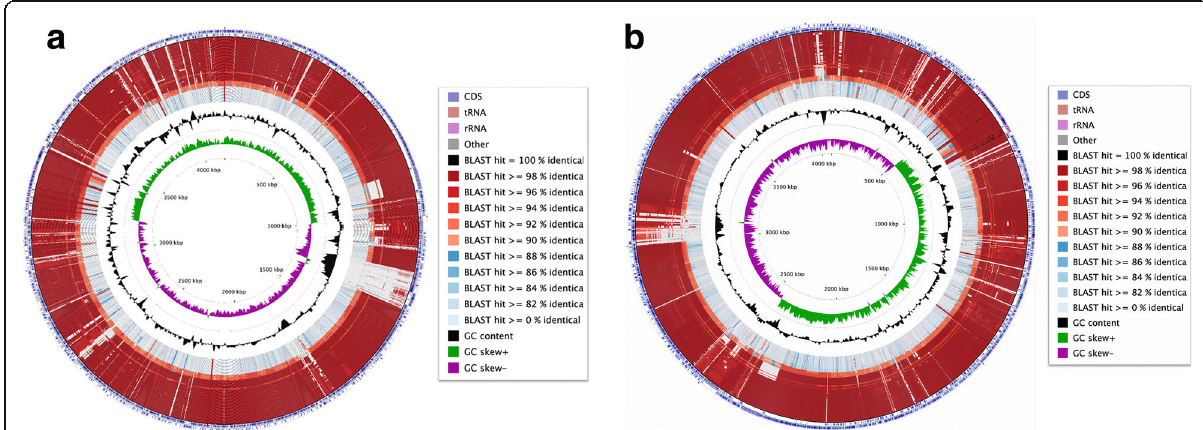
Fig. 2 a Visualizing features, ORFs, start and stop codons of B. subtilis HMNig-2 genome, and comparing the sequence with proteins encoded by other B. subtilis . This map was generated by CGview. The first and second [outermost] rings show the locations of protein coding, tRNA, and rRNA genes on the forward and reverse strands, respectively. All subsequent rings, with the exception of the two innermost plots, display regions of similarity detected using BLAST [ E value = 0.1] between the HMNig-2 genome sequence and the genome sequences of several related sequences [ n = 100]. Regions of similarity are colored based on the percent identity between the aligned sequence segments. The black plot depicts GC content with the peaks extending towards the outside of the circle representing GC content above the genome average, whereas those extending towards the center mark segments with GC content lower than the genome average. The innermost plot depicts GC skew. Both base composition plots were generated using a sliding window of 50,000 nt. b Visualizing features, ORFs, start and stop codons of B. subtilis MENO2 genome, and comparing the sequence with proteins encoded by other B. subtilis . This map was generated by CGview. The first and second [outermost] rings show the locations of protein coding, tRNA, and rRNA genes on the forward and reverse strands, respectively. All subsequent rings, with the exception of the two innermost plots, display regions of similarity detected using BLAST [ E value = 0.1] between the MENO2 genome sequence and the genome sequences of several related sequences [ n = 100]. Regions of similarity are colored based on the percent identity between the aligned sequence segments. The black plot depicts GC content with the peaks extending towards the outside of the circle representing GC content above the genome average, whereas those extending towards the center mark segments with GC content lower than the genome average. The innermost plot depicts GC skew. Both base composition plots were generated using a sliding